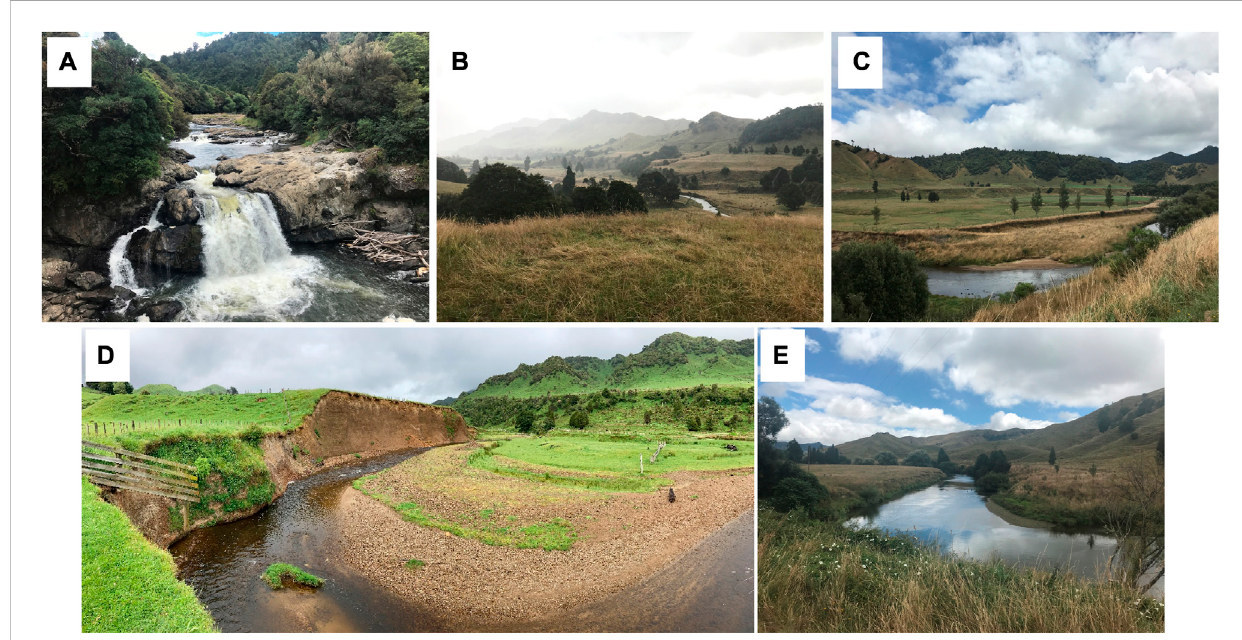
(Figure 10E; sensu Reid and Brierley, 2015). Sediment fi ngerprinting identi fi es stream bank erosion as the dominant